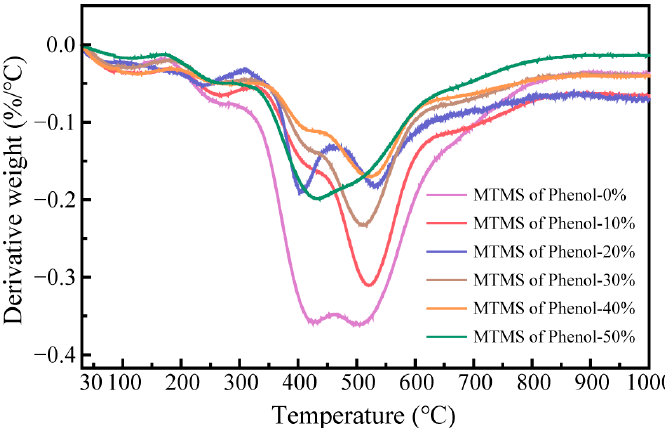
Figure 9. DTG of phenolic resin modified with different content of MTMS at 30~1000 °C.